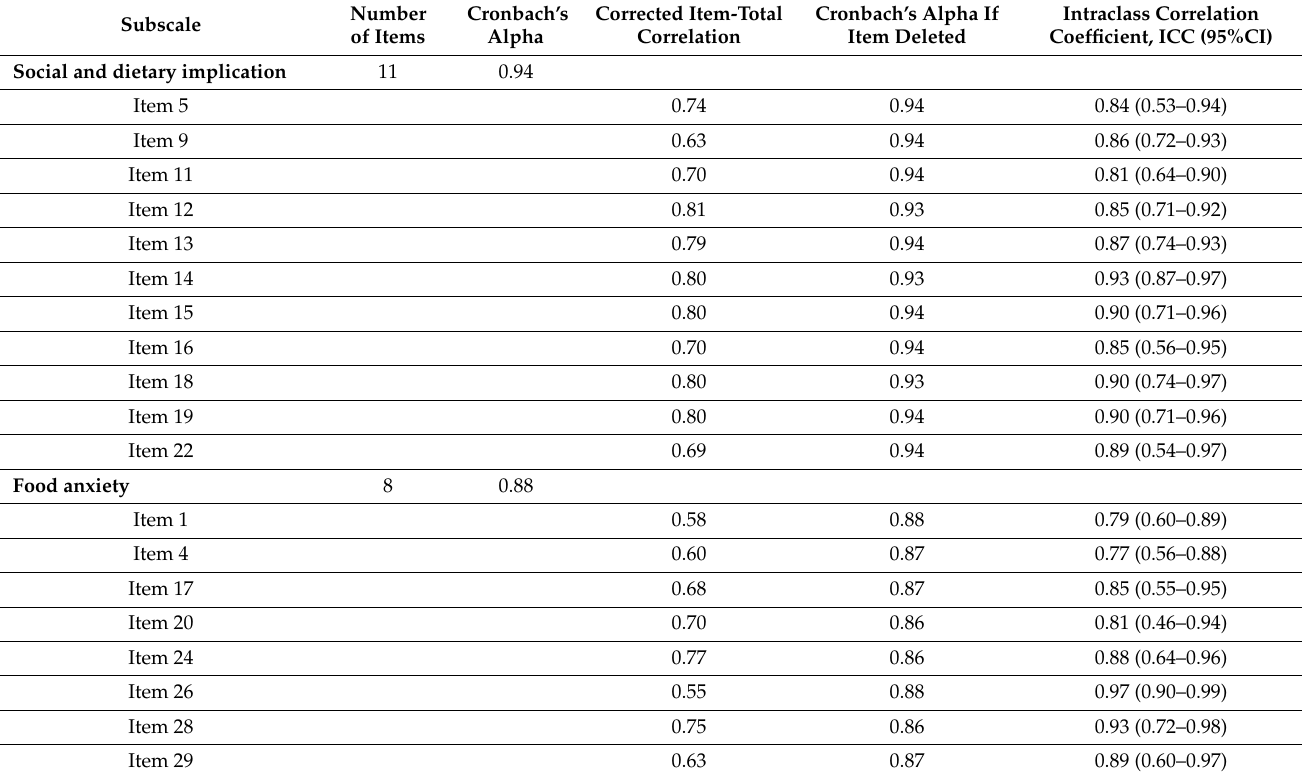
Table 3. Cronbach’s alpha values for each subscale and intraclass correlation coefficients (ICCs) for each